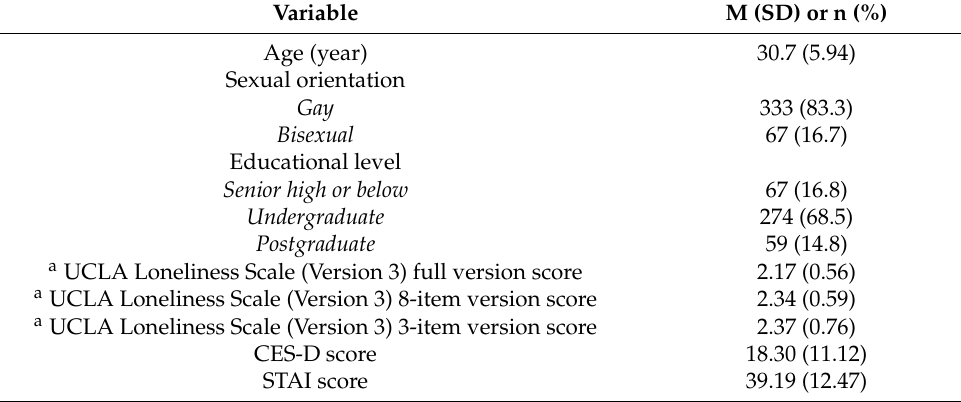
Table 1. Participants’ characteristics (N =